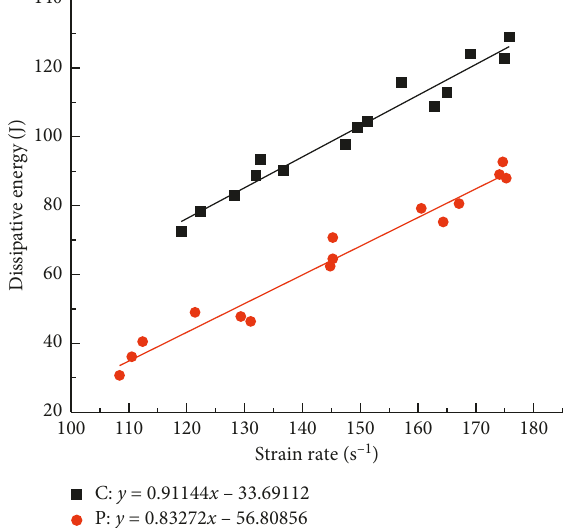
Figure 7: Relationship between dissipative energy and strain rate for parallel- (P-) bedding and vertical- (C-) bedding